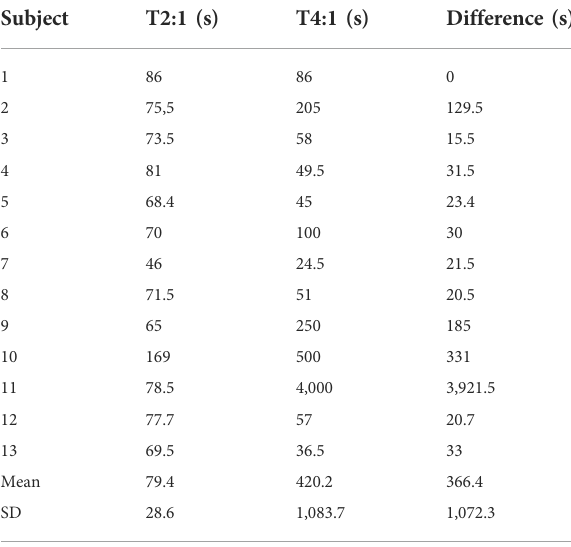
TABLE1Themeanandindividualvaluesofactualtime constantofthe reconstitution of the D 9 found by an iterative process from T2: